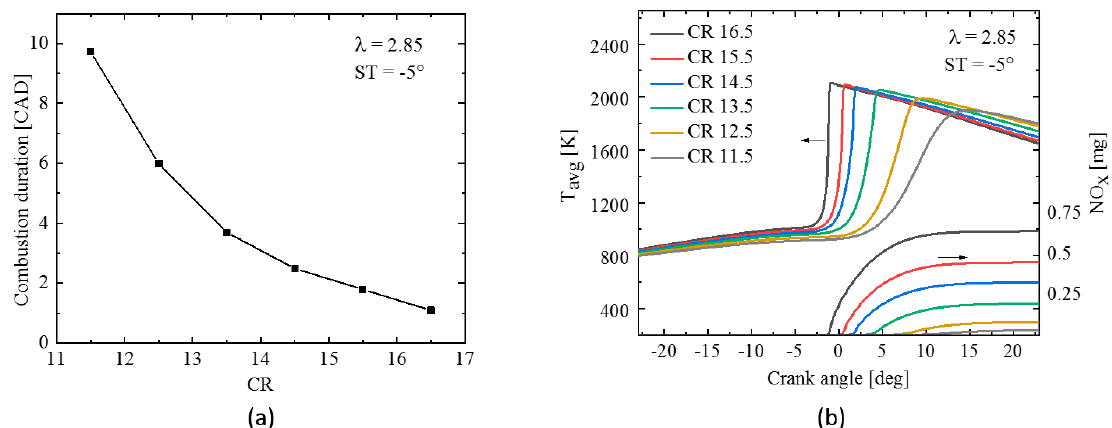
Figure 7. Comparison of: ( a ) pressure trace and heat release rate traces; and ( b ) efficiency for λ = 2.85 and ST = − 5 CAD at different CRs.